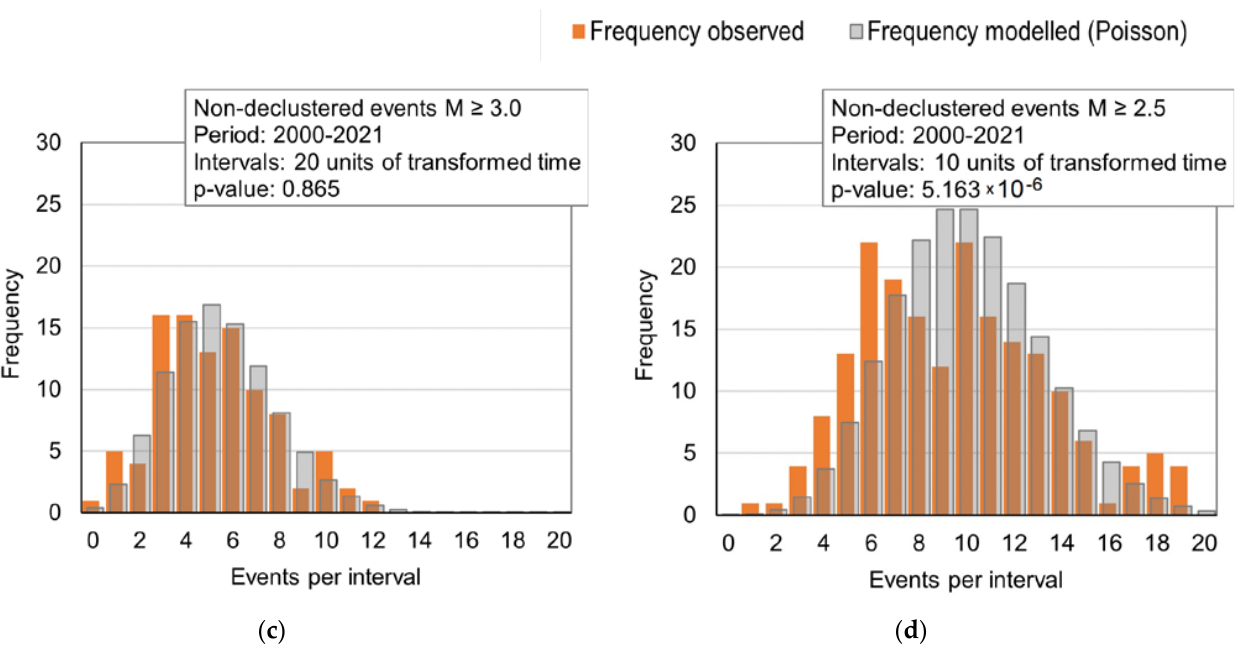
Figure 7. Examples of chi-squared Poisson goodness-of-fit tests: The distribution of event counts per interval are compared to the modelled Poisson distribution for ( a ) background events in the core area, M ≥ 3.0; ( b ) background events in the core area, M ≥ 2.5; ( c ) all events, M ≥ 3.0; and ( d ) all events, M ≥